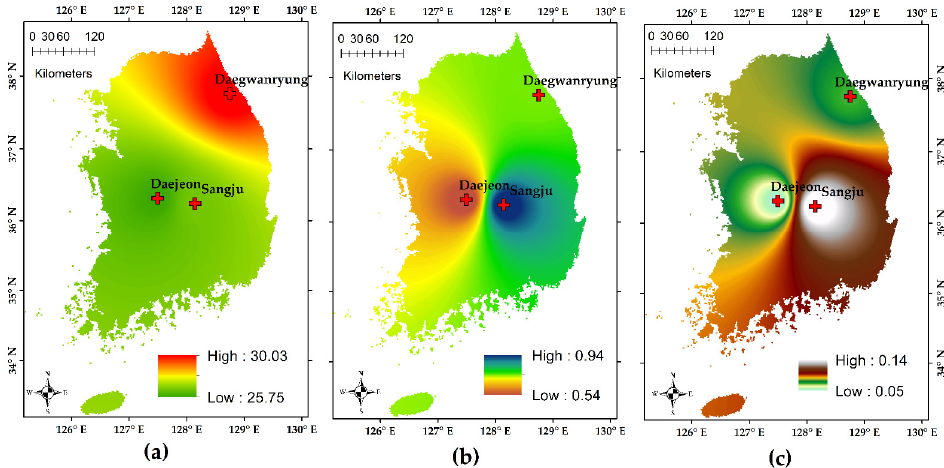
Figure 9. Spatial patterns of the ( a ) a , ( b ) b , and ( c ) c parameters in Equation (2) interpolated by the Inverse Distance Weighted (IDW) algorithm.